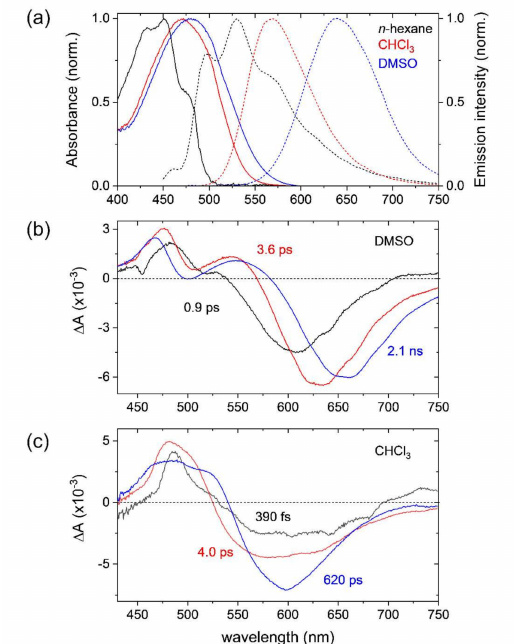
Figure 1. ( a ) Absorption (solid lines) and emission (dotted lines) spectra of DCM in n -hexane, CHCl 3 , and dimethylsulfoxide (DMSO) solutions. The excitations at 405 ( n -hexane) and 485 nm (CHCl 3 and DMSO) were used for the emission measurements; the evolution associated di ff erence spectra (EADS) of DCM in ( b ) DMSO and ( c ) CHCl 3 solution for the transient absorption results obtained with 403 nm